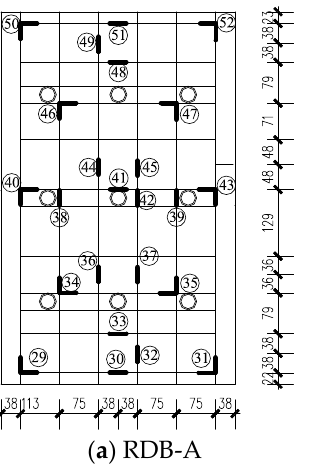
Figure 3. Arrangement of uniaxial strain gauges on the reinforcing bars.